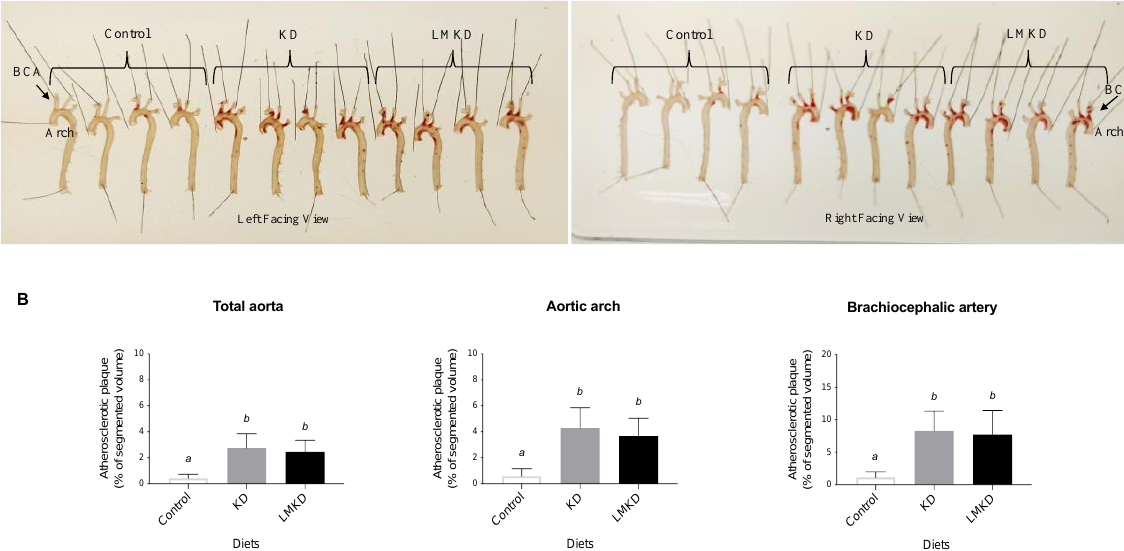
Figure 4. The effect of the experimental diets (ketogenic diet, KD; low methyl ketogenic diet, LMKD; and control) on aortic plaque burden. ( A ) Representative images of aortas from mice fed the experimental diets, after lipid staining (in red) with Oil Red-O (both sides of the aortas are shown), showing the localization of the aortic arch and brachiocephalic artery (BCA). ( B ) Volumetric assessment of plaque burden in different aortic segments by 14T-MRI. Data shown are the mean ± SD, n = 4–6/group. Bars bearing different letters were significantly different ( p <